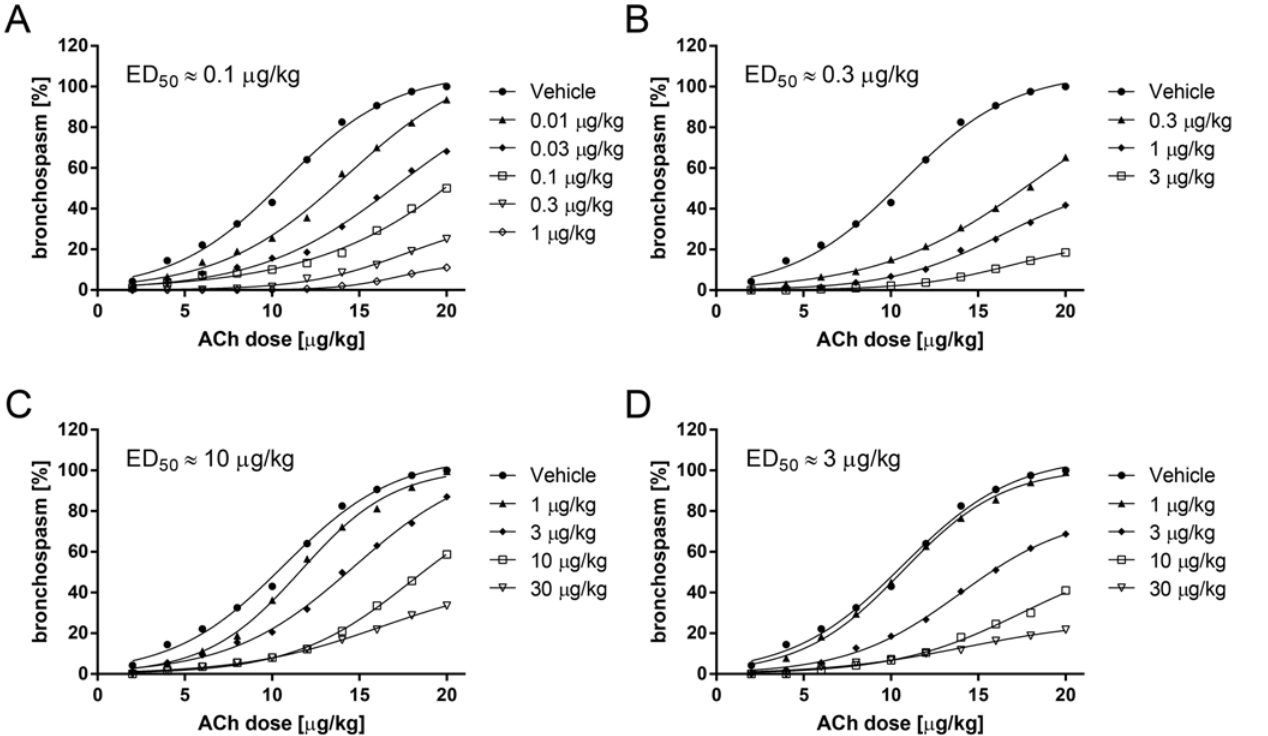
Fig 2. Therapeutic dose of β 2 -agonists in a model of acetylcholine-induced bronchoconstriction in anaesthetized guinea pigs.